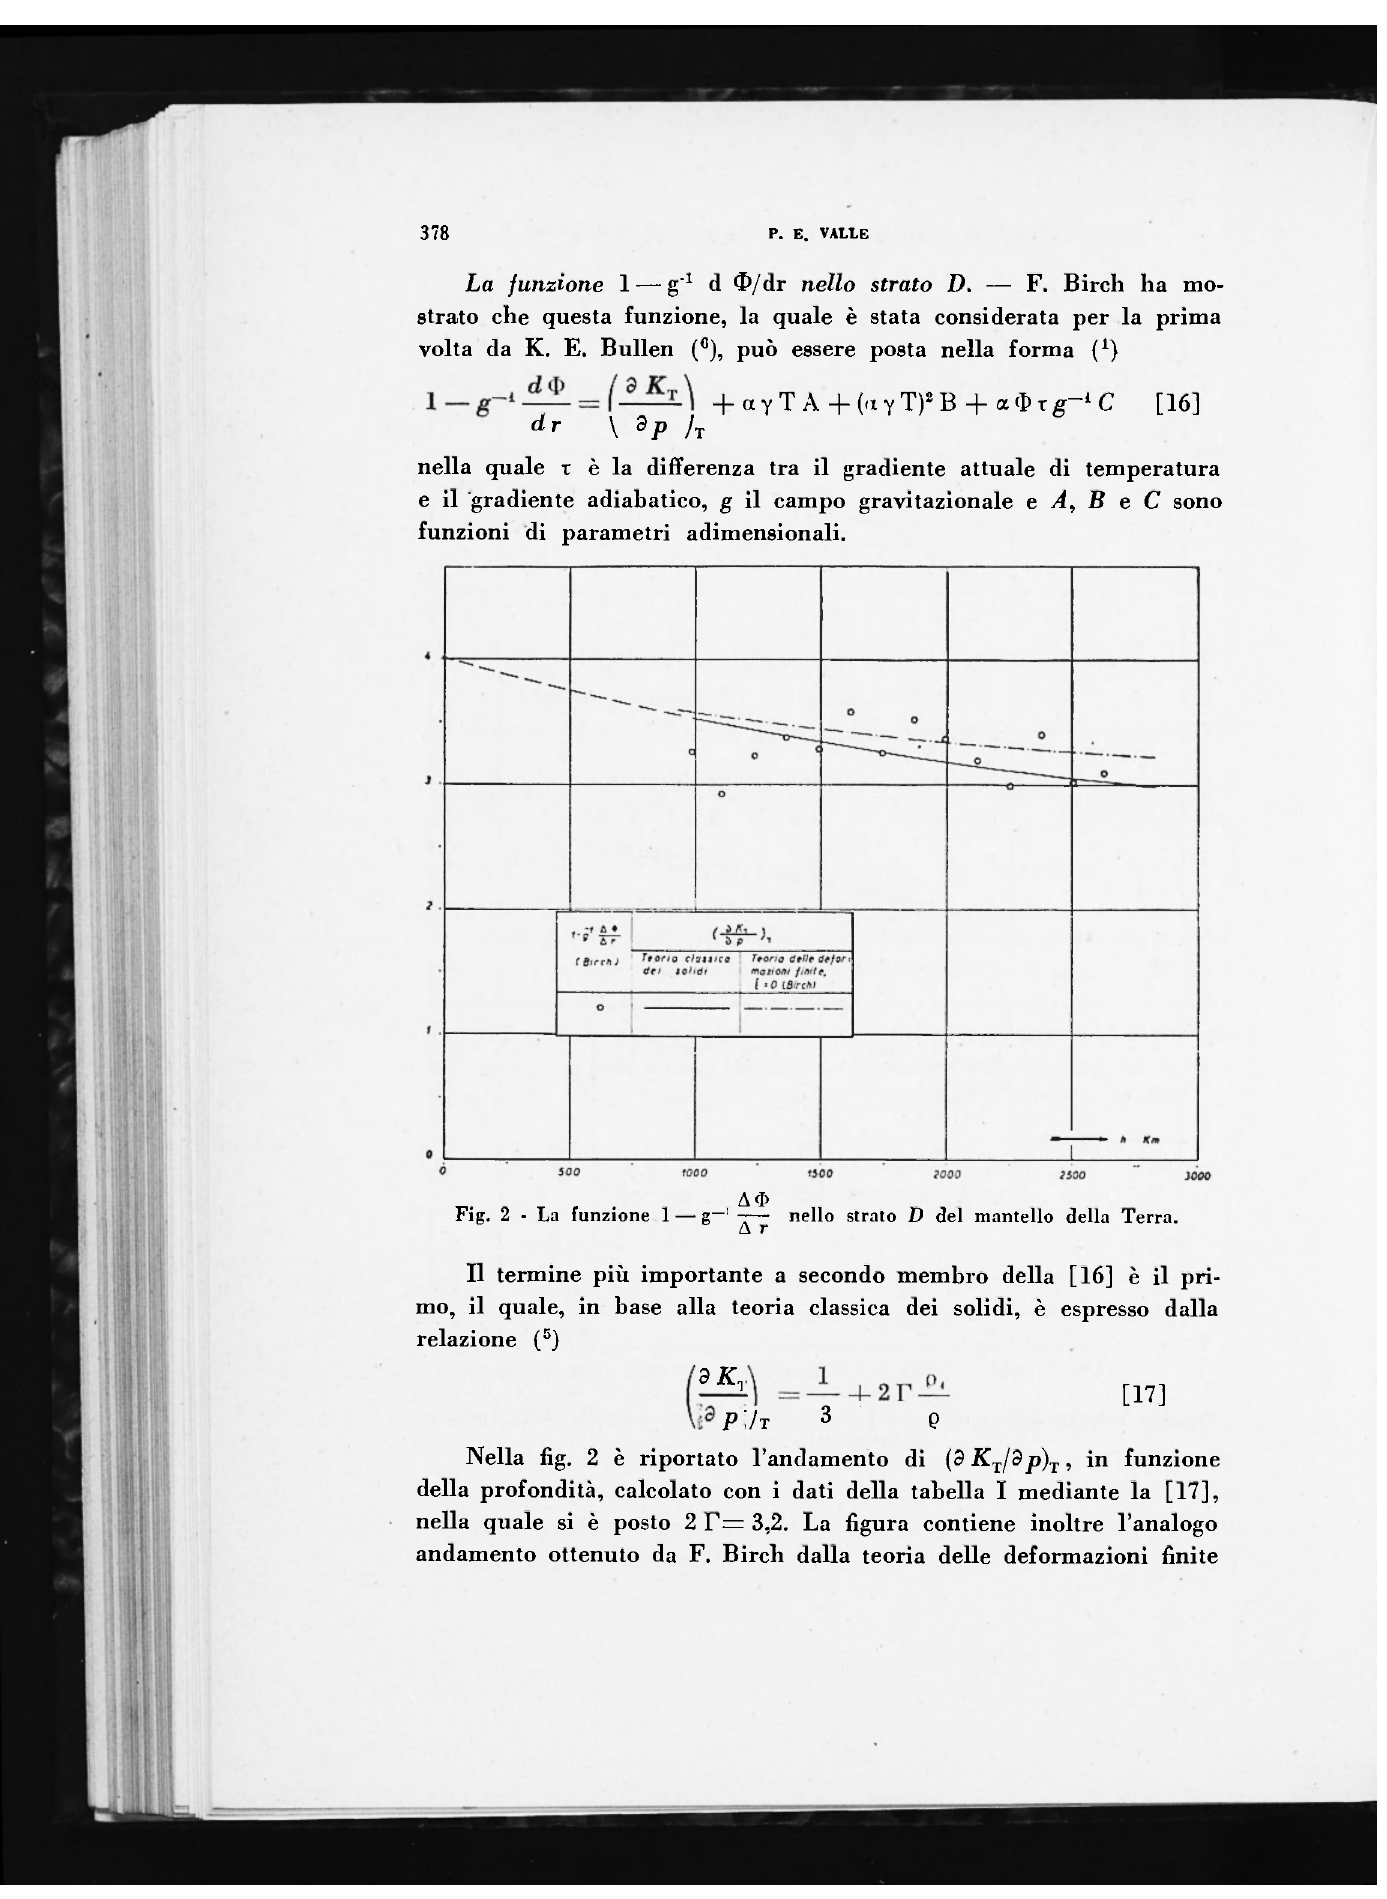
Nella fig. 2 è riportato l'andamento di (3 K T /dp). r